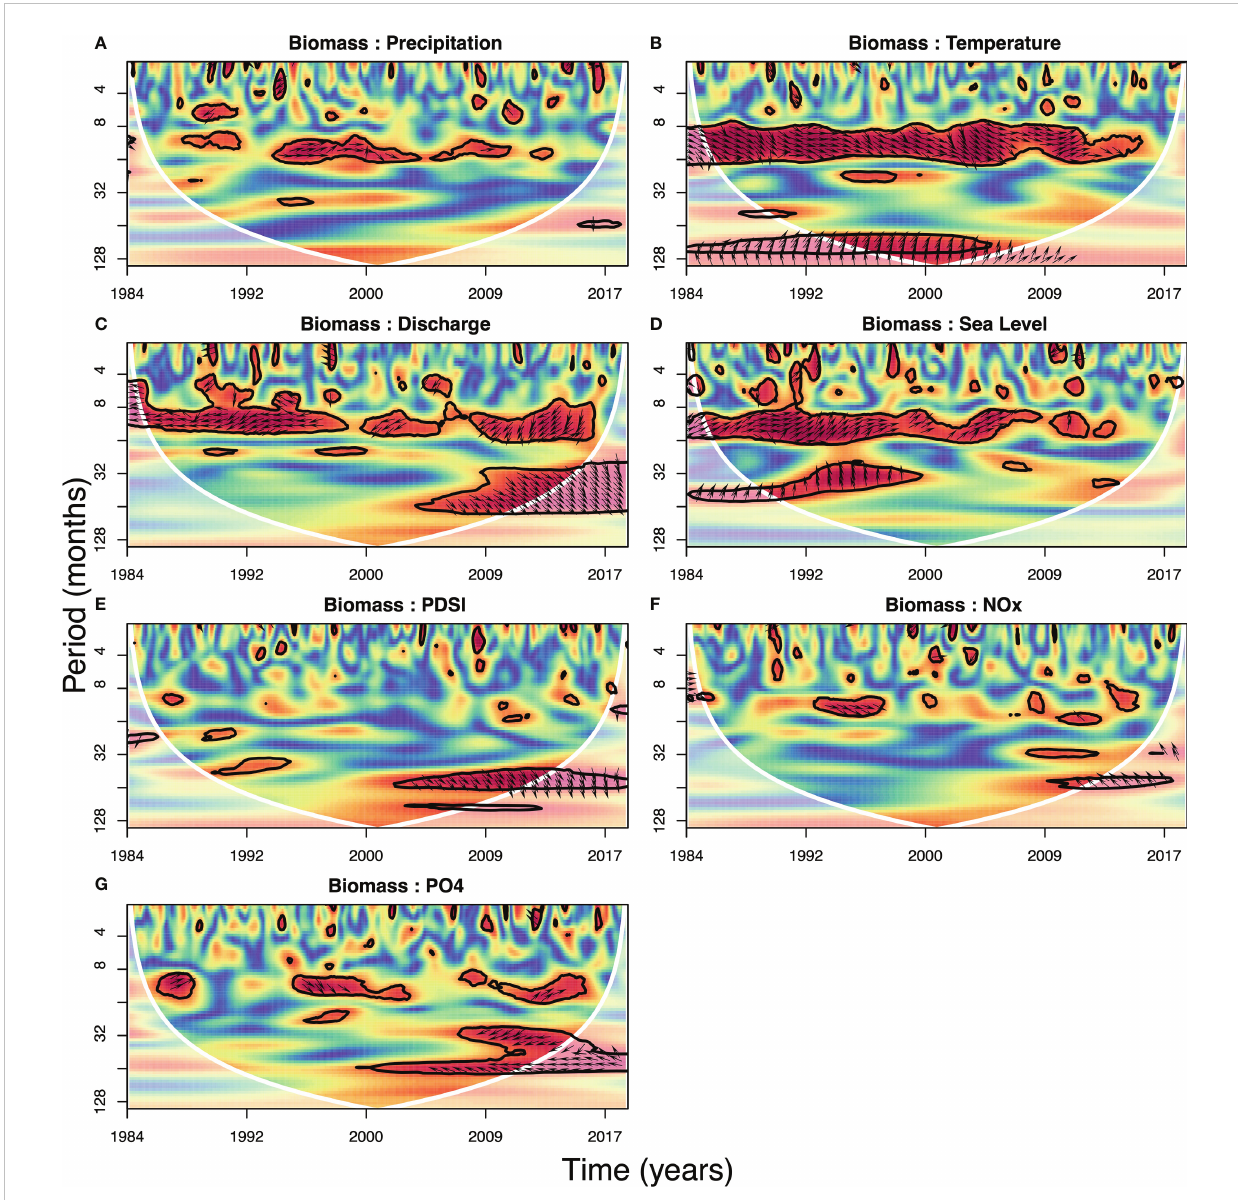
FIGURE 5 Wavelet coherence for biomass with other variables: precipitation (A) , temperature (B) , discharge (C) , sea level (D) , PDSI (E) , NO x (F) and PO 43 – (G) . Colors indicate the normalized wavelet coherence between two signals ranging from 1 (red, high correlation) to 0 (blue, low correlation) (Grinsted et al., 2004). Phase differences are indicated by arrows and increase from arrows pointing right (in phase, no phase difference) to arrows pointing left (anti-phase, completely out of phase). Arrows pointing down (up) mean that the environmental variable is leading biomass with one fourth (three fourth) of the period (i.e., 3 months or 9 months in the annual band). Black lines outline time-frequency couples that show signi fi cance (95% con fi dence level) and white lines indicate the cone of in fl uence where values outside the line are prone to edge